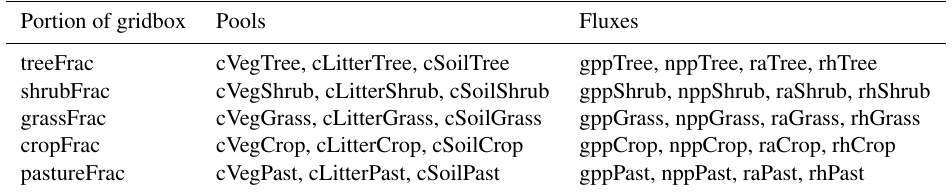
Table 3. Summary of tier-2 data request of carbon pools and fluxes by sub-grid land cover fraction. Portion of gridbox